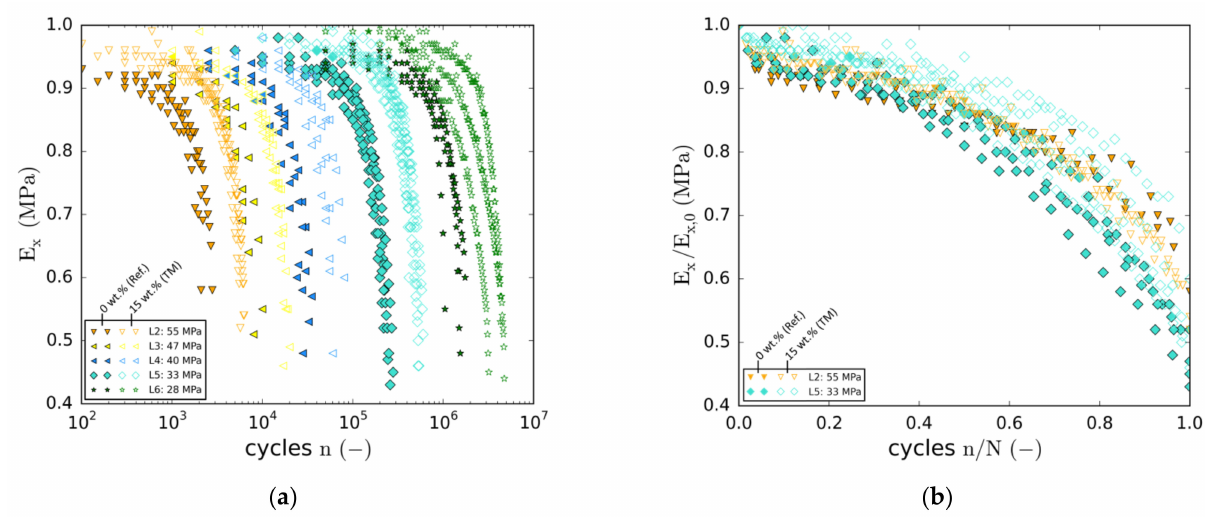
Figure 10. ( a ) Normalised tangent modulus against cycle number (all load levels); ( b ) Normalised modulus against normalised cycle number (two representative load